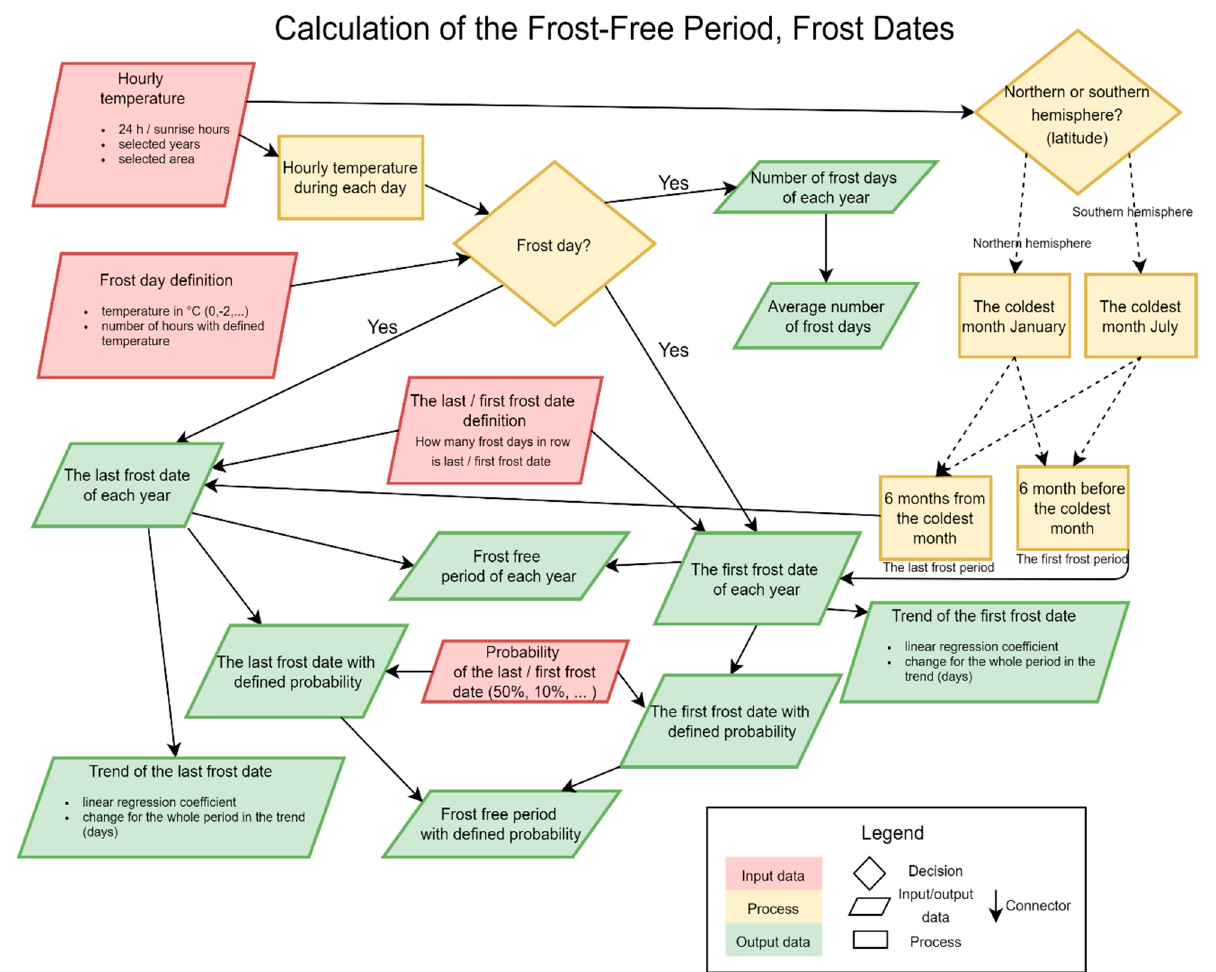
Figure 3. Scheme of the algorithm for calculation frost dates and frost-free period (adapted from [29]).